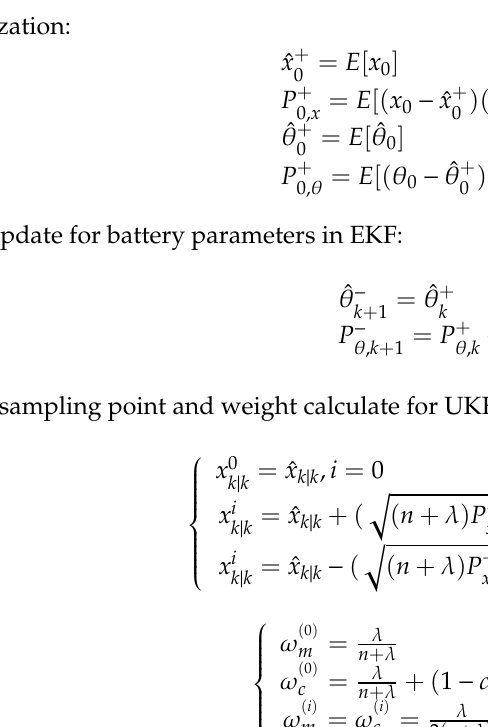
Figure 2. Flow chart of the unscented Kalman filter–extended Kalman filter (UKF–EKF).